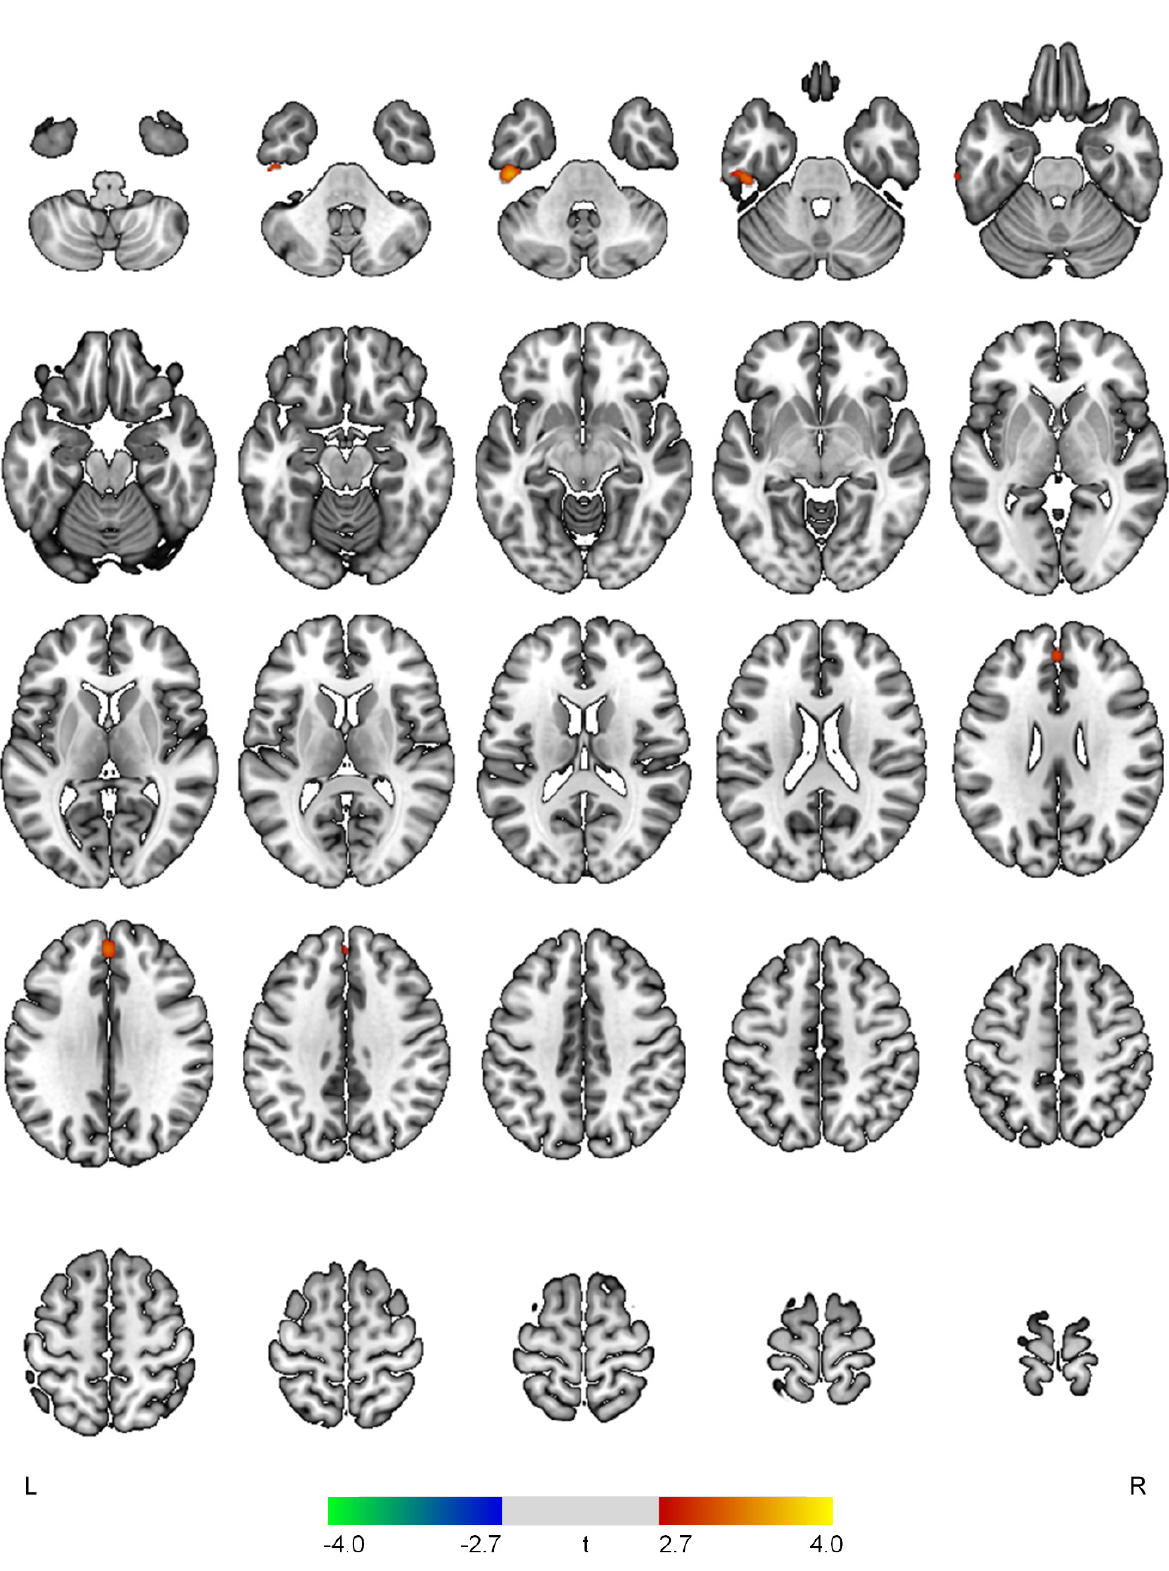
Figure 3. Positive (red-yellow) or negative (blue-green) correlations between regional cerebral blood flow and the hyperactivity domain in patients with early Alzheimer’s disease. The color bar represents t values at each voxel. L —left; R —right.